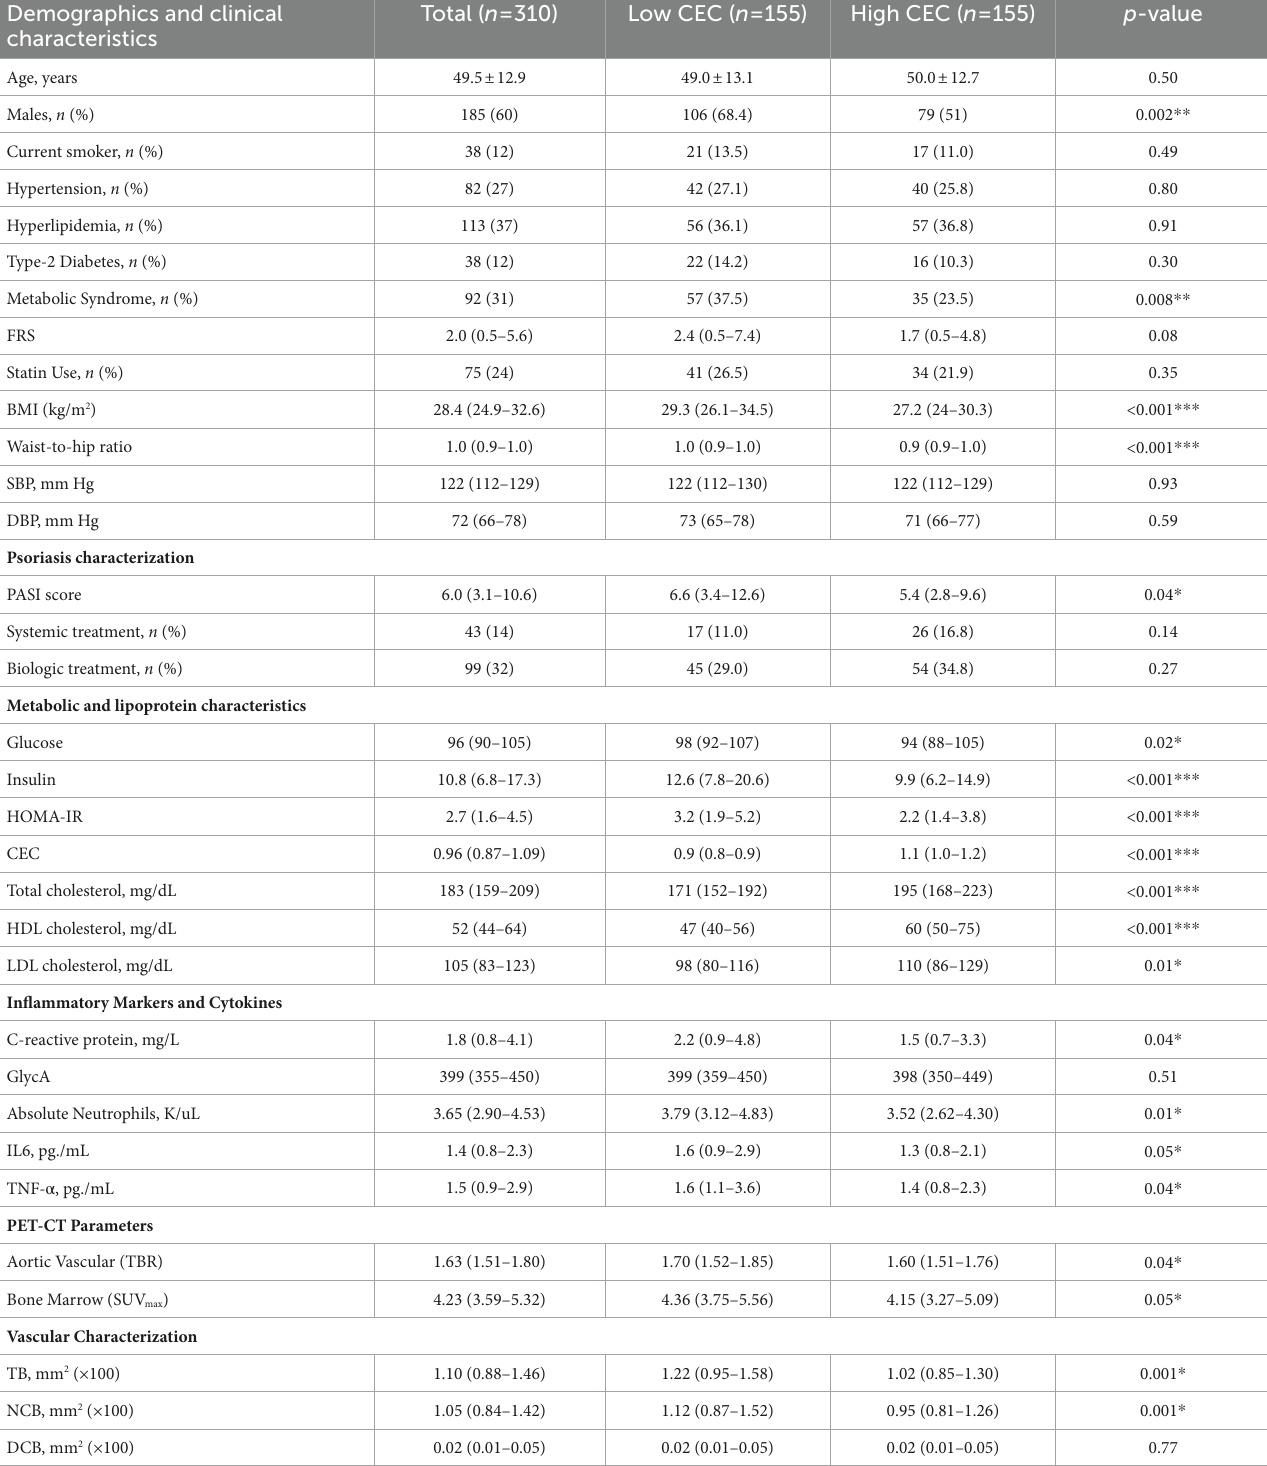
TABLE 1 Clinical characteristics of psoriasis patients stratified by median CEC (0.95). Demographics and clinical